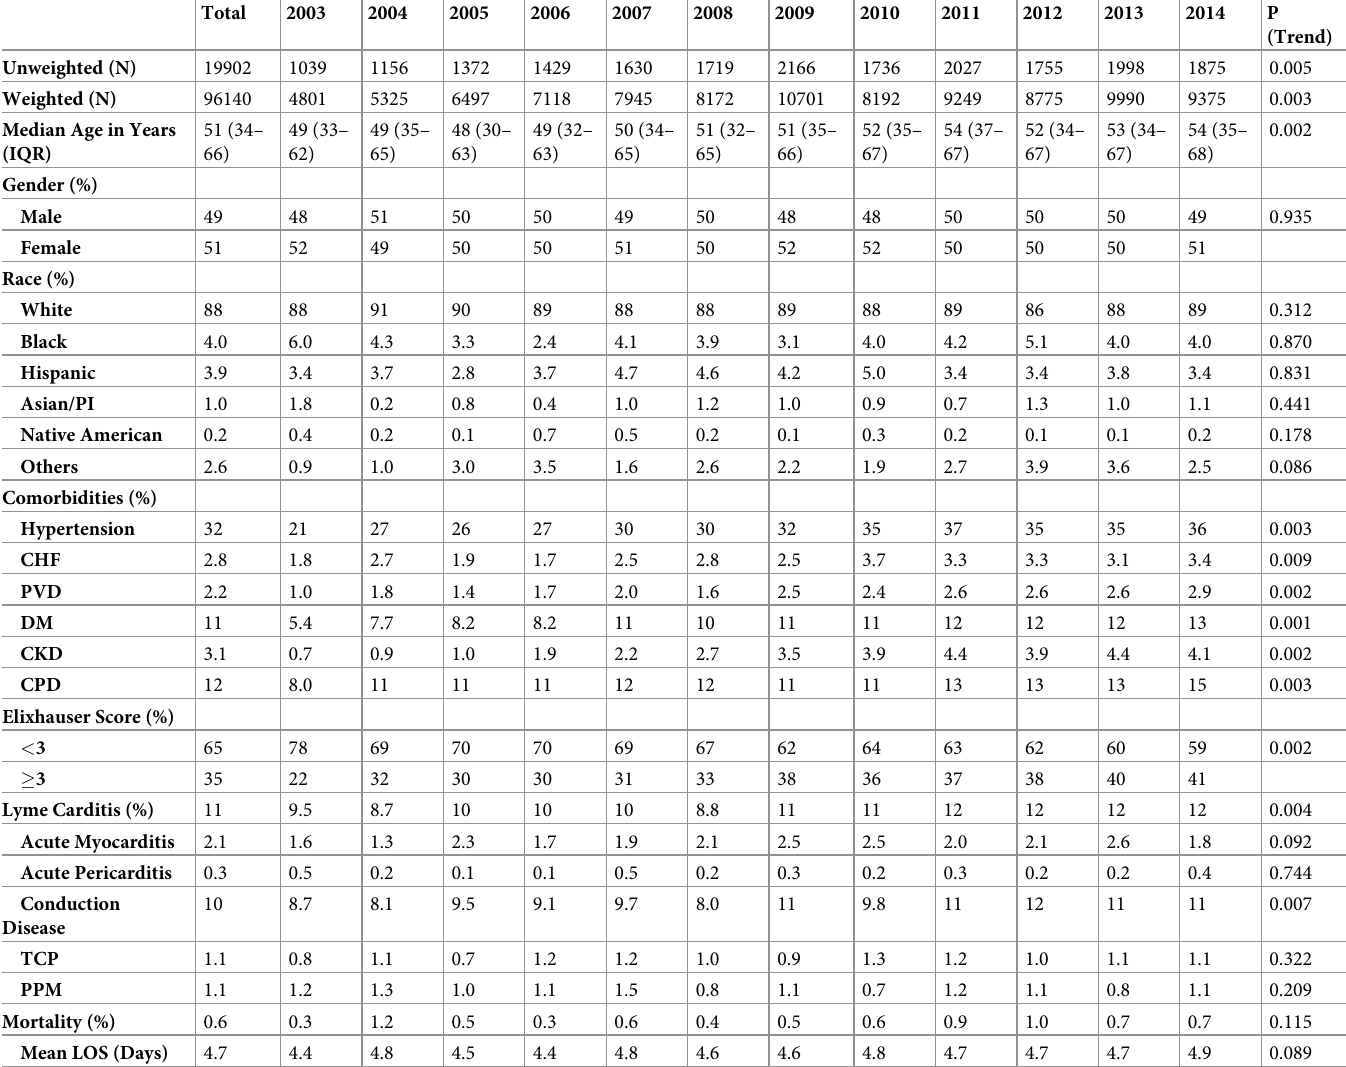
Table 1. Trends in baseline characteristics of patients hospitalized with Lyme disease in the U.S. between 2003 and